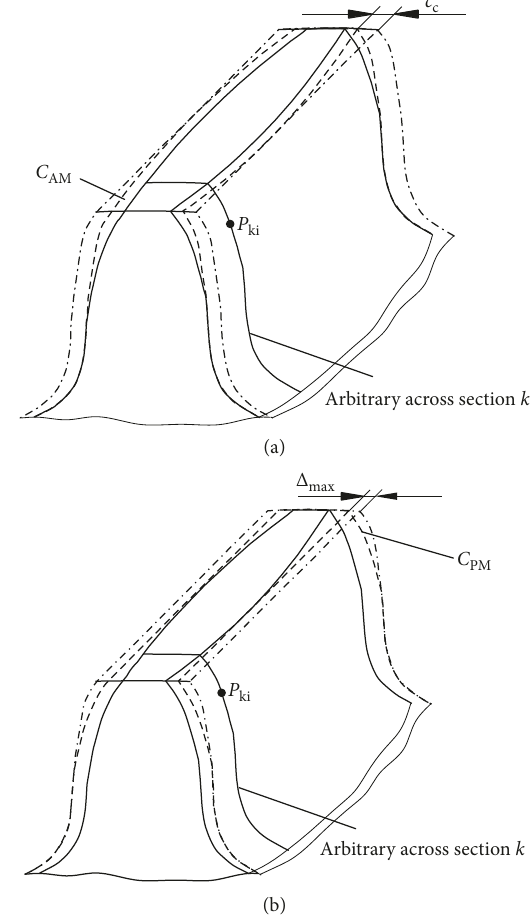
Figure 1: Shape of gear tooth. (a) Conducting axial modification for gear. (b) Conducting profile modification for